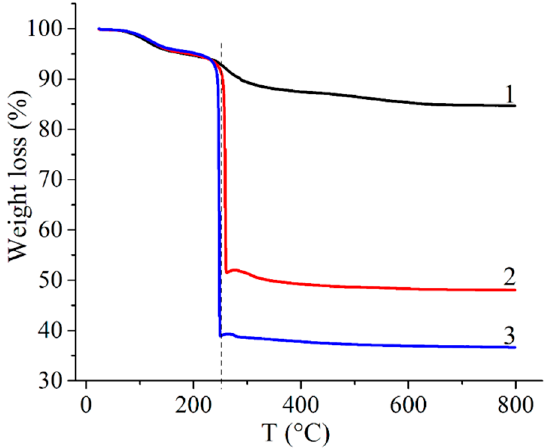
Figure 1. TGA curves of PVP-HA composites: 1—sample 1; 2—sample 2; 3—sample 3 (Table 1, samples 1–3, respectively).